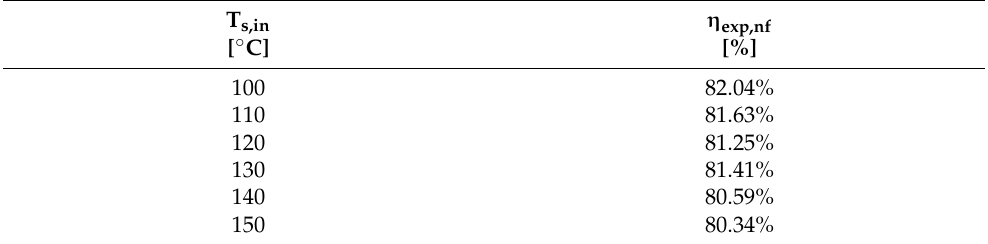
Table 3. Isentropic expander efficiency: optimization results at the considered heat source temperatures.